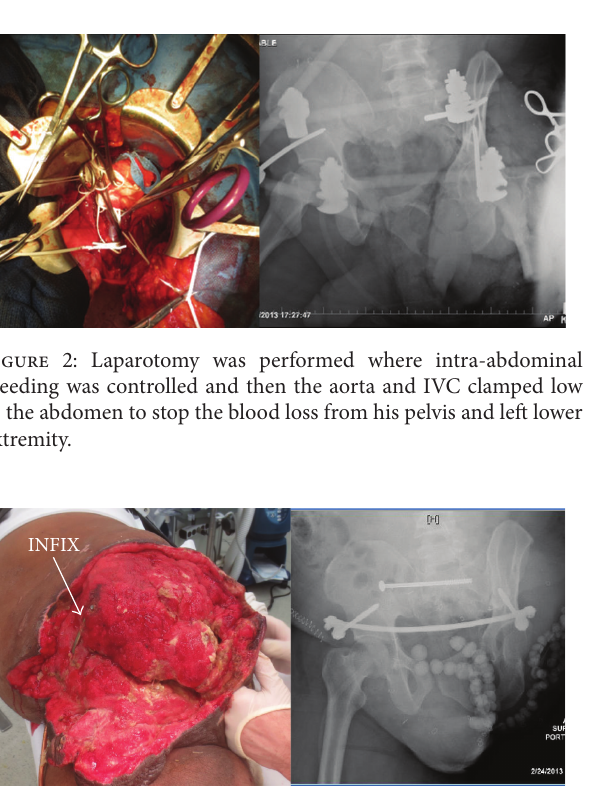
Figure 3: INFIX/EXFIX, as well as a percutaneous SI joint screw to stabilize the pelvis then antibiotic beads and wound vacs to combat the soft tissue